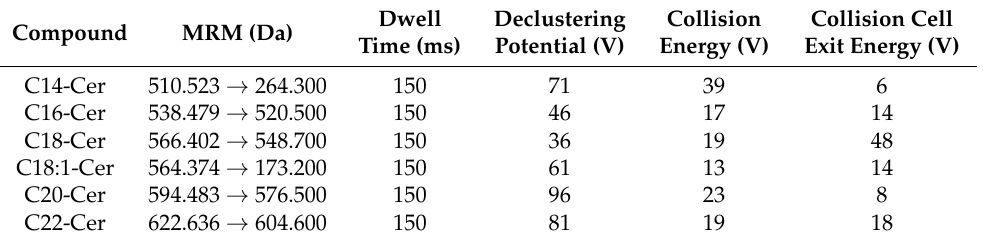
Table 1. Parameters used for the targeted analysis by mass spectrometry of ceramides reported in the